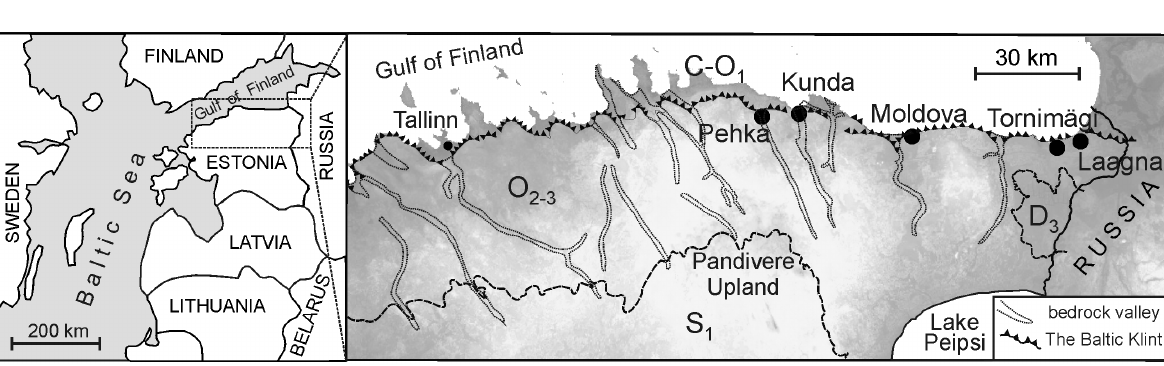
Fig. 1. Location of the studied sites on the edge of the Baltic Klint in northern Estonia. Shading indicates the topographic relief (darker means lower elevation, lighter (cid:150) higher elevation). Simplified bedrock geology: C(cid:150)O 1 , Cambrian and Lower Ordovician terrigenous rocks; O 2(cid:150)3 , Middle and Upper Ordovician carbonaceous rocks; S 1 , Lower Silurian carbonaceous rocks; D 3 , Upper Devonian carbonaceous